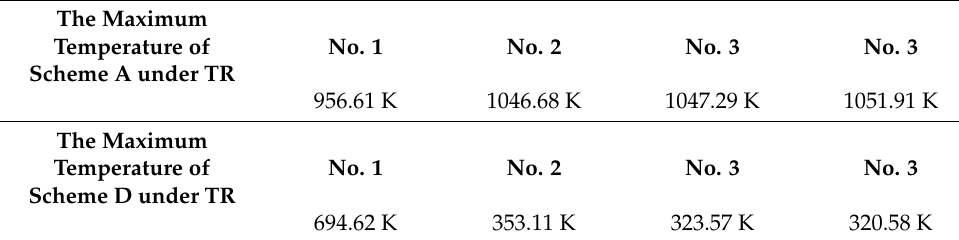
Table 5. The range/value of